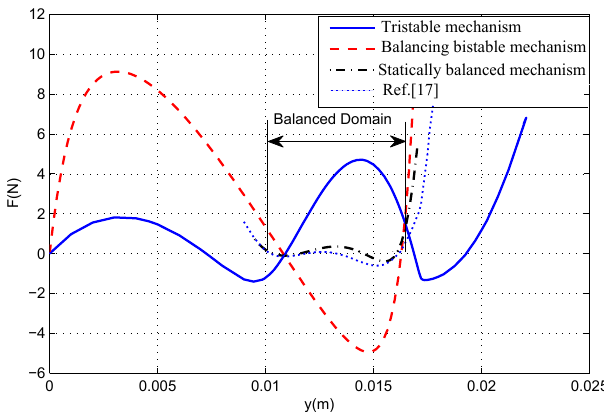
Figure 13. Force-displacement characteristics of the fully- compliant statically balanced mechanism.